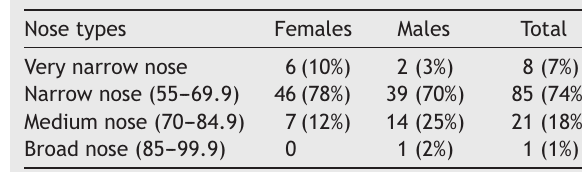
Number and percentage of individuals among var- ious nose types of young Turkish females and males.